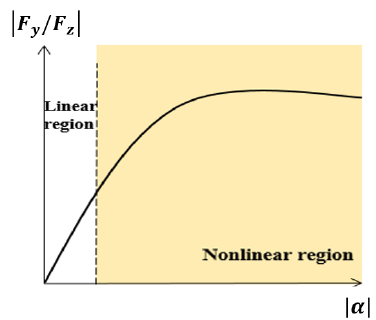
Figure 2. Normalized lateral tire force versus tire slip angle.